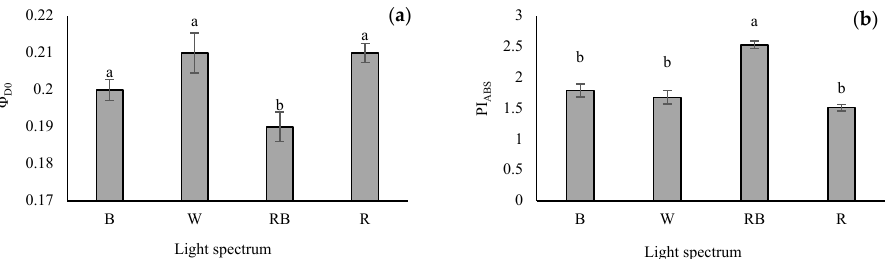
Figure 5. The quantum yield of energy dissipation ( ϕ D0 ; ( a )), and performance index in light absorption basis (PI ABS ; ( b )) from the fluorescence transient exhibited by leaves sampled from grafted tomato seedlings exposed to different light qualities (including white (W; 35% B, 49% intermediate spectra, 16% R) light as control, blue (B), red (R), and a combination of red (68%) and blue (RB), (see the correspondence spectrum in Figure 1)), with 75 ± 5 µmol m − 2 s − 1 PPFD for 20 days. Columns with the same le tt ers are not signi fi cantly di ff erent at p ≤ 0.05, according to Duncan ʹ s multiple range tests. Bars represent the mean value of three replications ± SEM.